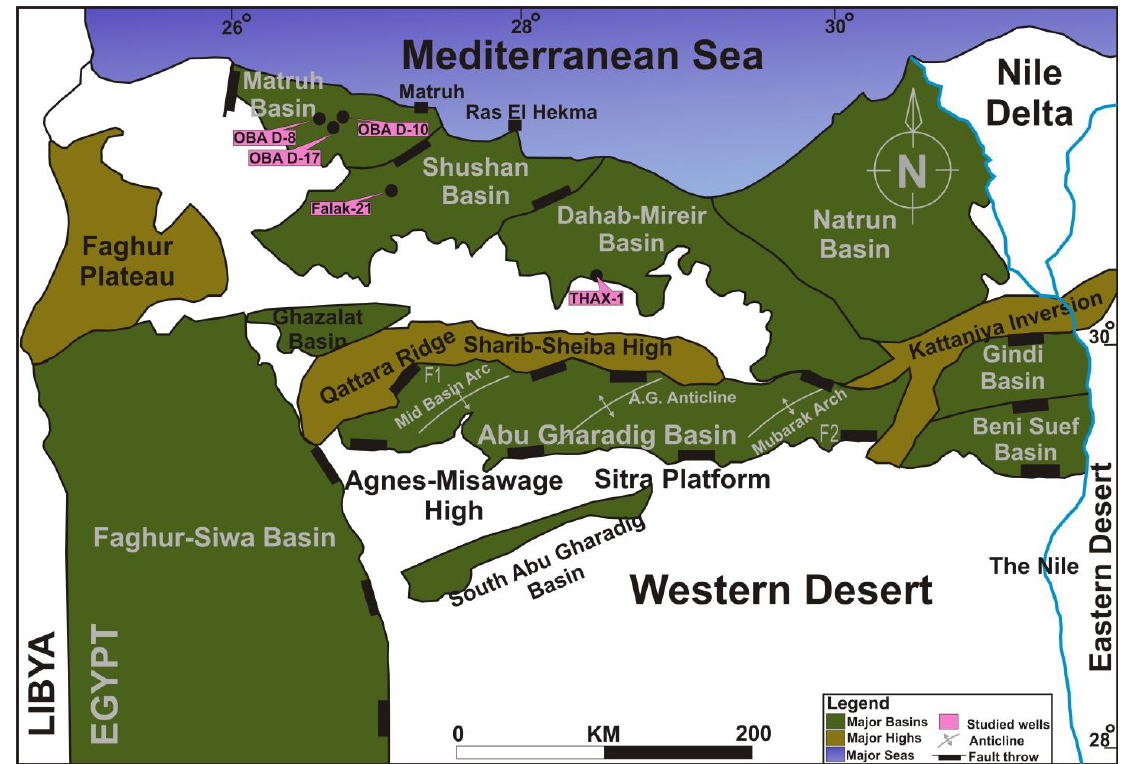
Figure 1. Major sedimentary basins, adjoining highs, and controlling structures of the north Western Desert (modified after EGPC [2]). The locations of the current study wells are also shown. The Khatatba Formation is the main source rock unit in the north Western Desert [2,4,5,8]. Although several organic geochemical investigations of the Khatatba Formation have assessed source rock potential and organic matter characteristics, the degree of